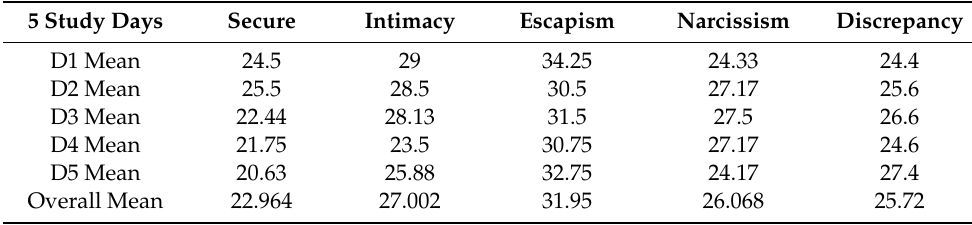
Table 20. Mean scores by day and behavioural